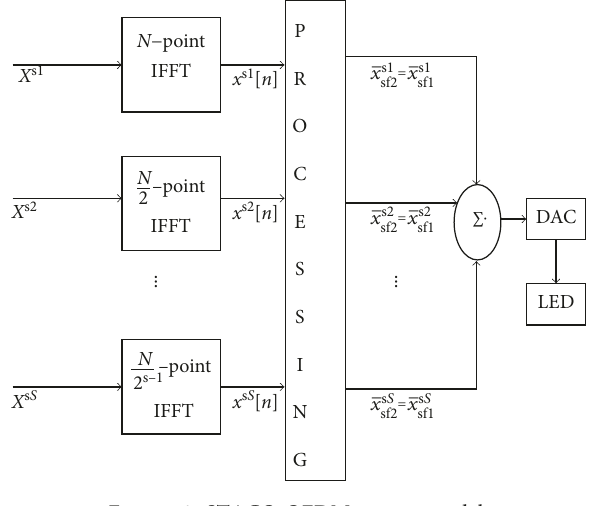
Figure 3: STACO-OFDM system